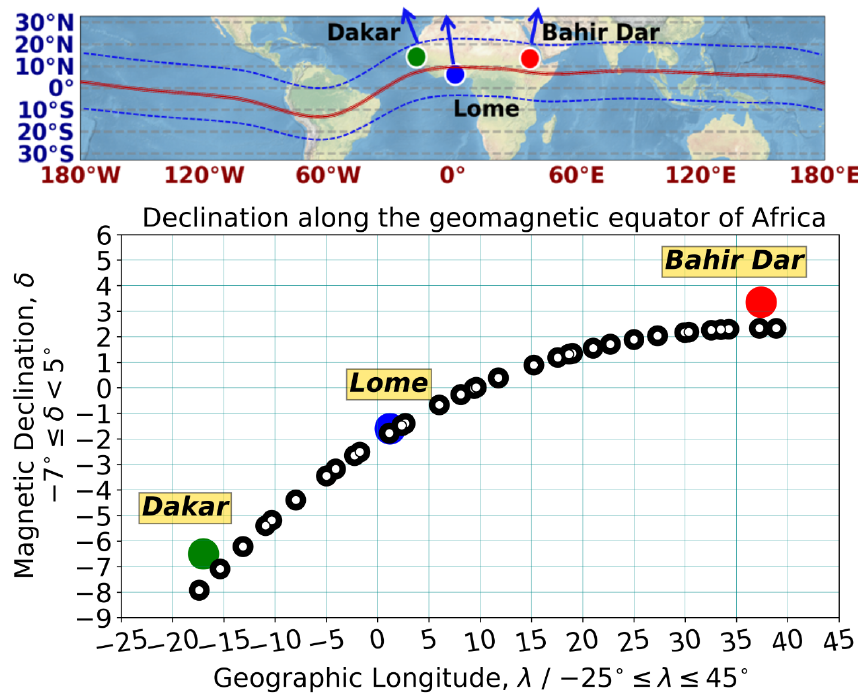
Figure 6. ( Upper panel ) Contours of the geomagnetic field at geomagnetic dip latitude of ± 15 ◦ characterizing regions of both crests (dashed blue lines) in the vicinity of the geomagnetic equator (red line). The direction of the geomagnetic declination at the selected three stations over Africa (Dakar— green dot, Lomé—blue dot and Bahir Dar—red dot) is indicated by a blue arrow. ( Lower panel ) Black circles indicate the declination along the geomagnetic equator of Africa obtained by a polynomial fitting technique (positive east, negative west) and the declination values at the three